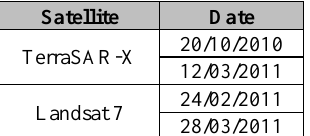
Table 1. Images that were used in the